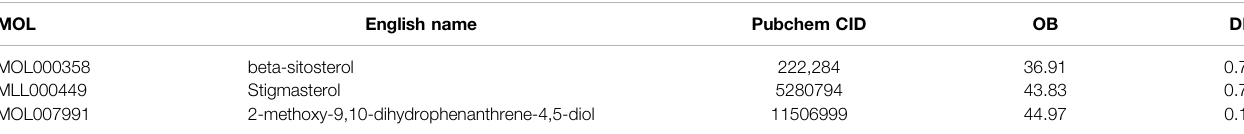
TABLE 1 | Active ingredients of Shan Ci Gu. MOL